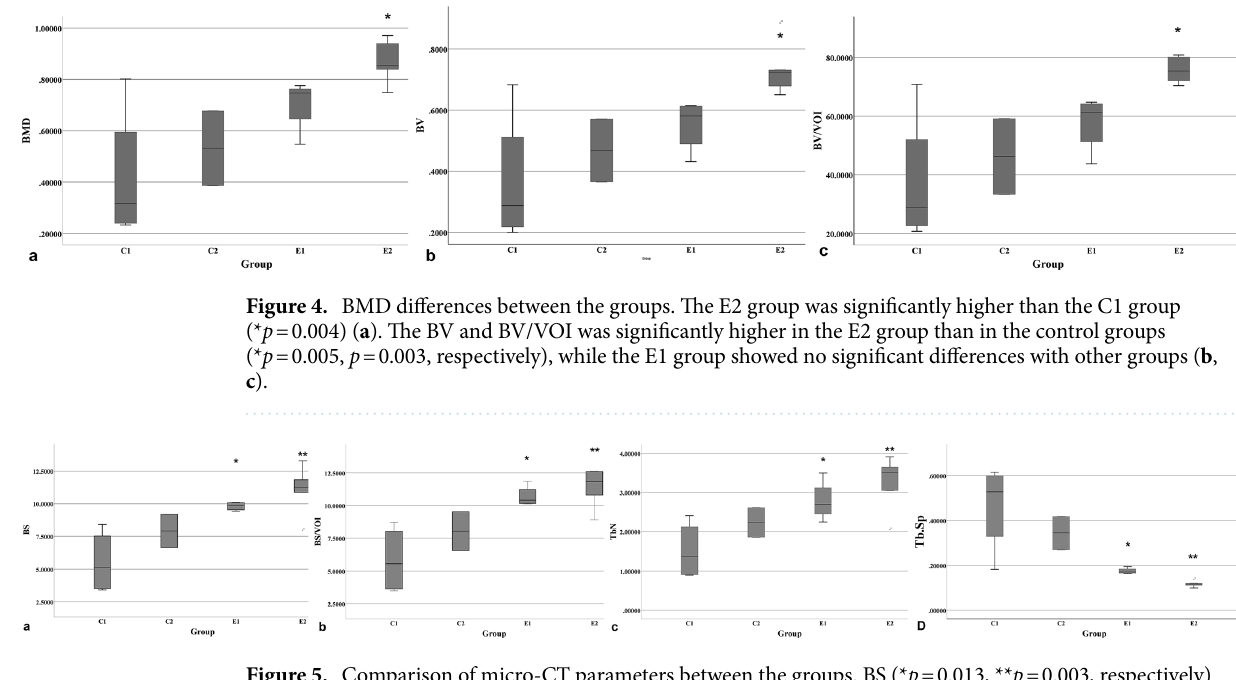
Figure 5. Comparison of micro-CT parameters between the groups. BS (* p = 0.013, ** p = 0.003, respectively) ( a ), bone surface and BS/VOI ( b ) (* p = 0.012, ** p = 0.002, respectively), Tb.N ( c ) (* p = 0.031, ** p = 0.004, respectively), Tb.Sp ( d ) (* p = 0.026, ** p = 0.002,